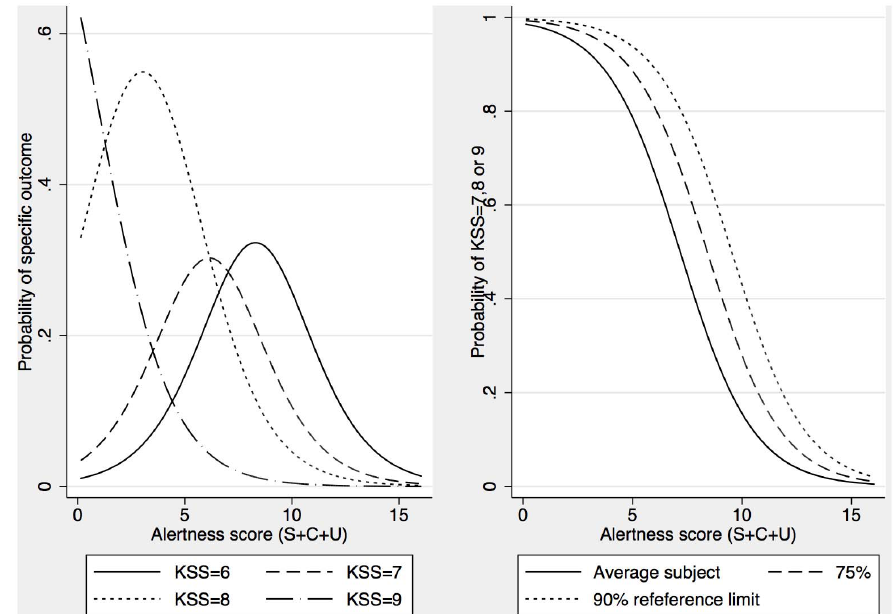
Figure 5. Predicted probabilities as a function of alertness score (S B + C + U) based on equation 17. Left panel shows probabilities for specific outcomes (KSS=6–9) and right panel shows probabilities for severe sleepiness (KSS $ 7) with reference limits accounting for 75% and 90% of subjects (below the line) in addition to the average subject (i.e. 50% reference limit). doi:10.1371/journal.pone.0108679.g005 The empirical Bayes’ estimates of individual phases were subjected to a standard cross-sectional linear regression model with one observation for each subject and circadian type as the independent variable to get a predicted phase adjustment for process C (and U) based on the circadian type question.